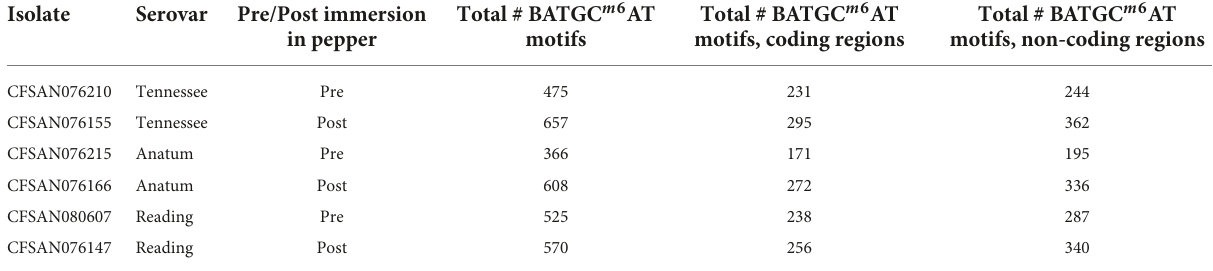
TABLE 3 Total number of BATGC m 6 AT motifs present in the genomes. Isolate Serovar Pre/Post immersion